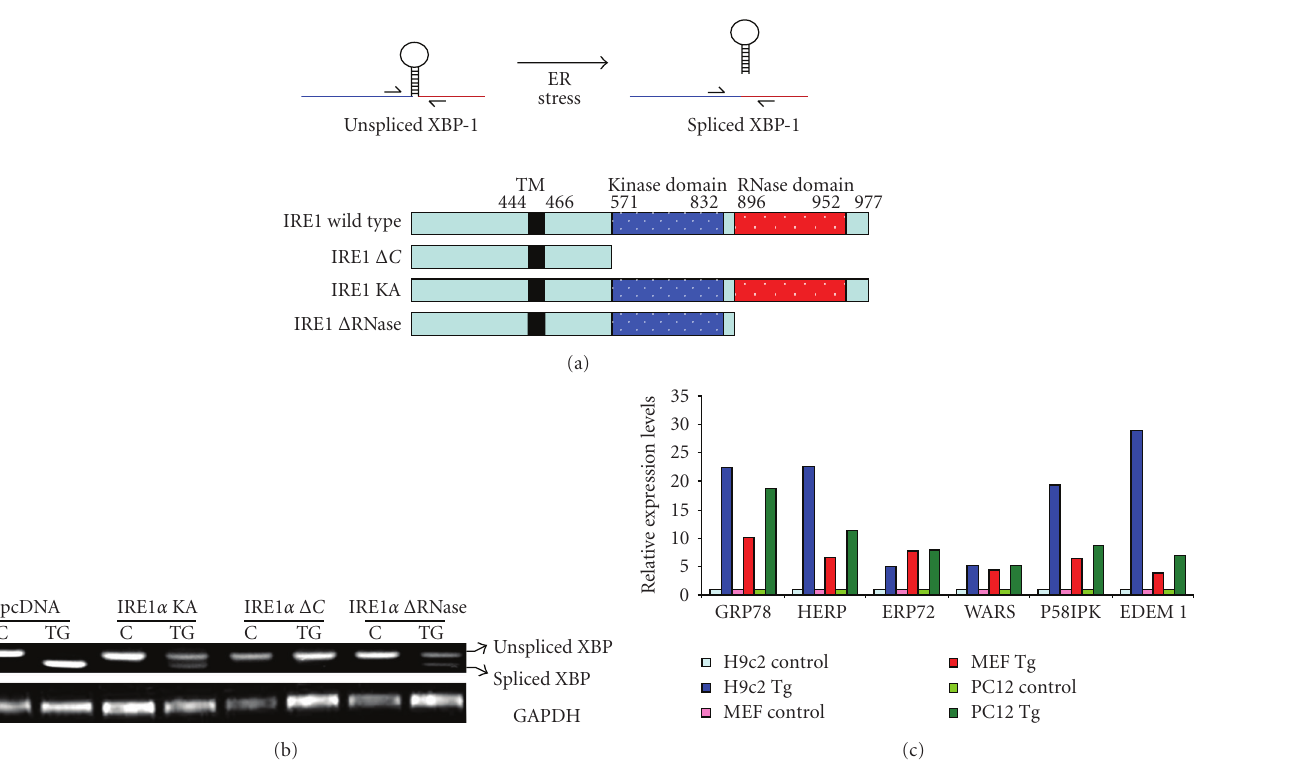
Figure 1: Detection of transcript levels of UPR target genes by RT-PCR . (a) Upper panel, cartoon of XBP1 splicing during ER stress. Lower panel, schematic representation of various mutant constructs of IRE1. (b) Modulation of XBP1 splicing by mutant IRE1. Total RNA was isolated from HEK 293 cells that were transfected with IRE1 mutants, either untreated or treated with thapsigargin (0.5 μ M) 6 hours, and RT-PCR analysis of total RNA was performed to simultaneously detect both spliced and unspliced XBP1 mRNA and GADPH. (c) Induction of UPR target genes upon exposure to thapsigargin. Total RNA was isolated from indicated cells after treatment thapsigargin (Tg), and the expression levels of the indicated genes were determined by real-time RT-PCR, normalizing against GAPDH